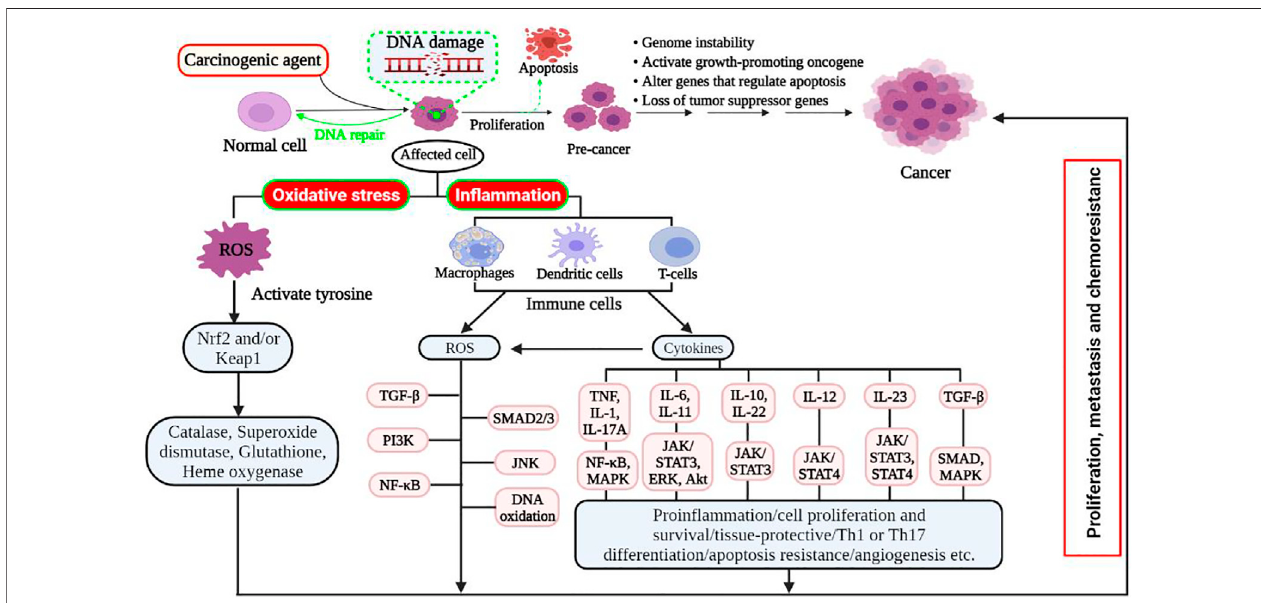
FIGURE 3 | Schematic mechanism of oxidative stress and in fl ammation-induced cancer development. Damaged cells or tissues produce ROS resulting in oxidative stress and/or in fl ammation. Oxidative stress: regenerated ROS can be detoxi fi ed with the presence of balanced detoxifying agents, such as antioxidants. However, excessive ROS induces apoptotic signalling pathways and promotes carcinogenesis in cells with faulty signalling by deregulating biomolecules. Hence, it targets Nrf2 and its regulator Keap1 and downregulates antioxidant enzymes that result in high intracellular ROS levels, which induce cell proliferation, metastasis, and chemoresistance by rescuing Nrf2 transcription. In fl ammation: various diseases and stress conditions causes in fl ammatory cell in fi ltration that induces ROS and differentcytokines.TheelevatedROSactivateslatentTGF-complex,whichbindstoitsreceptorandactivatessignallingpathwayssuchSMAD2/3,PI3K,andJNK.Italso activated tyrosine kinase that allowed NF- κ B (active form) to enter the nucleus, further activating target genes for chemokines, cytokines, adhesion molecules, and receptors to cause cell proliferation, growth, and differentiation. Akt, protein kinase B; Erk, extracellular signal-regulated kinase; IL, interleukin; JNK, c-Jun N-terminal kinase; Keap1, kelch-like ECH (enoyl-CoA hydratase)-associated protein 1; MAPK, mitogen-activated protein kinase; Nrf2, nuclear-related factor 2; NF- κ B, nuclear factor-kappa B; Pi3K, Pi3 kinase; ROS, reactive oxygen species; STAT3, signal transducer and activator of transcription 3; SUZ12, suppressor of zeste 12; TGF, transforming growth factor; TNF, tumour necrosis